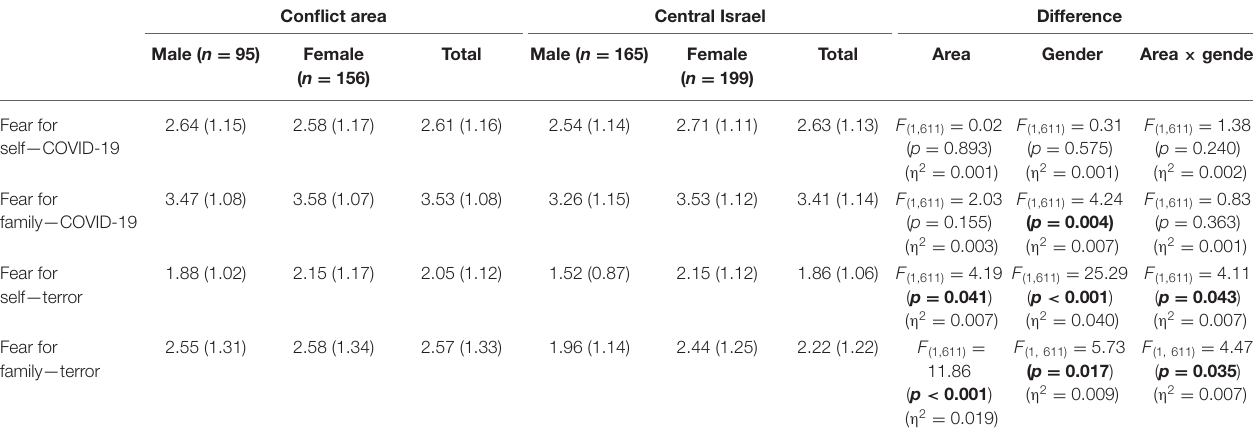
TABLE 1 | Distribution of the fear variables by area and gender ( N = 615). Conflict